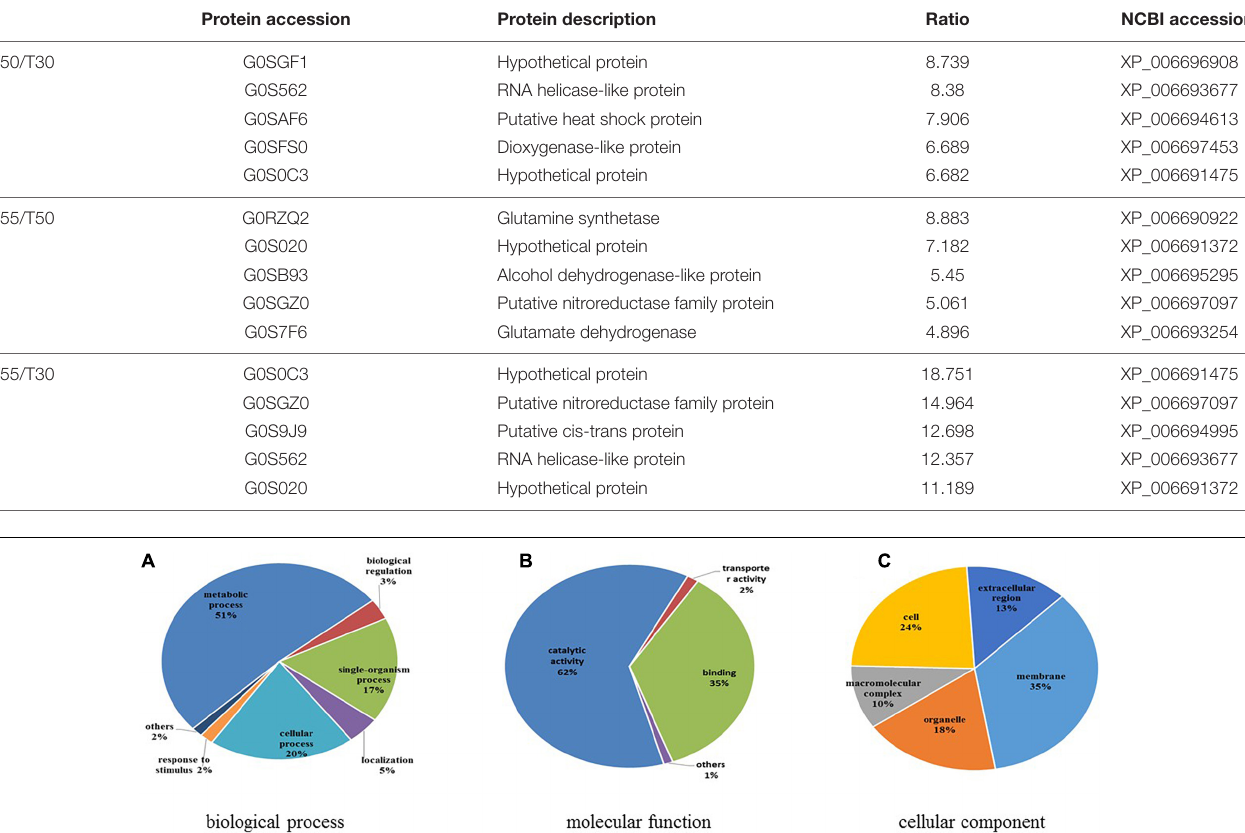
TABLE 1 | Five proteins with the highest differences in T50/T30, T55/T50, and T55/T30. Protein accession Protein description Ratio